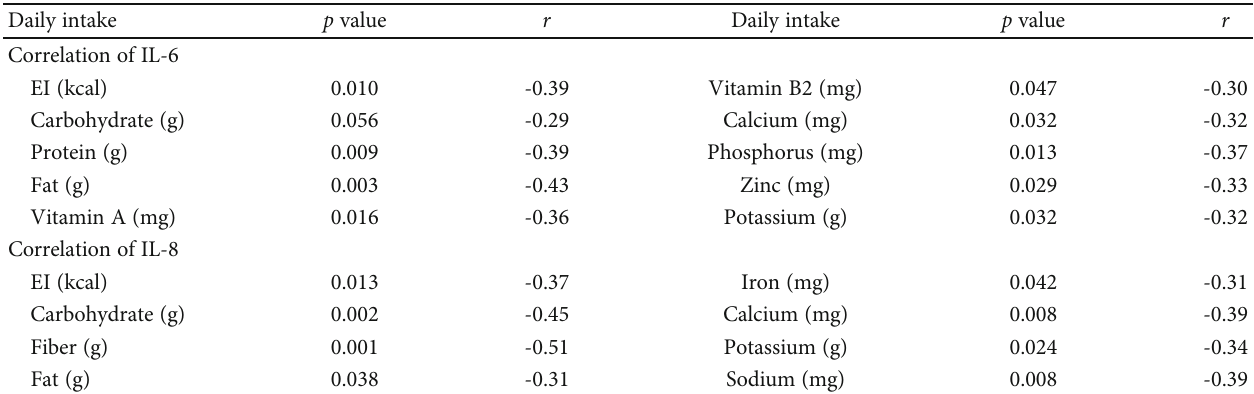
Table 3: Correlation of daily intake with interleukin-6 (IL-6) before the race and interleukin-8 (IL-8) after the race in marathon runners.